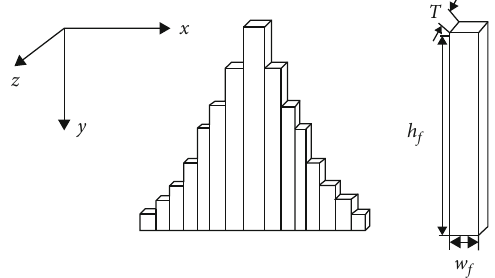
Figure 5: A sketch of the rectangular-slice model and a single LCM